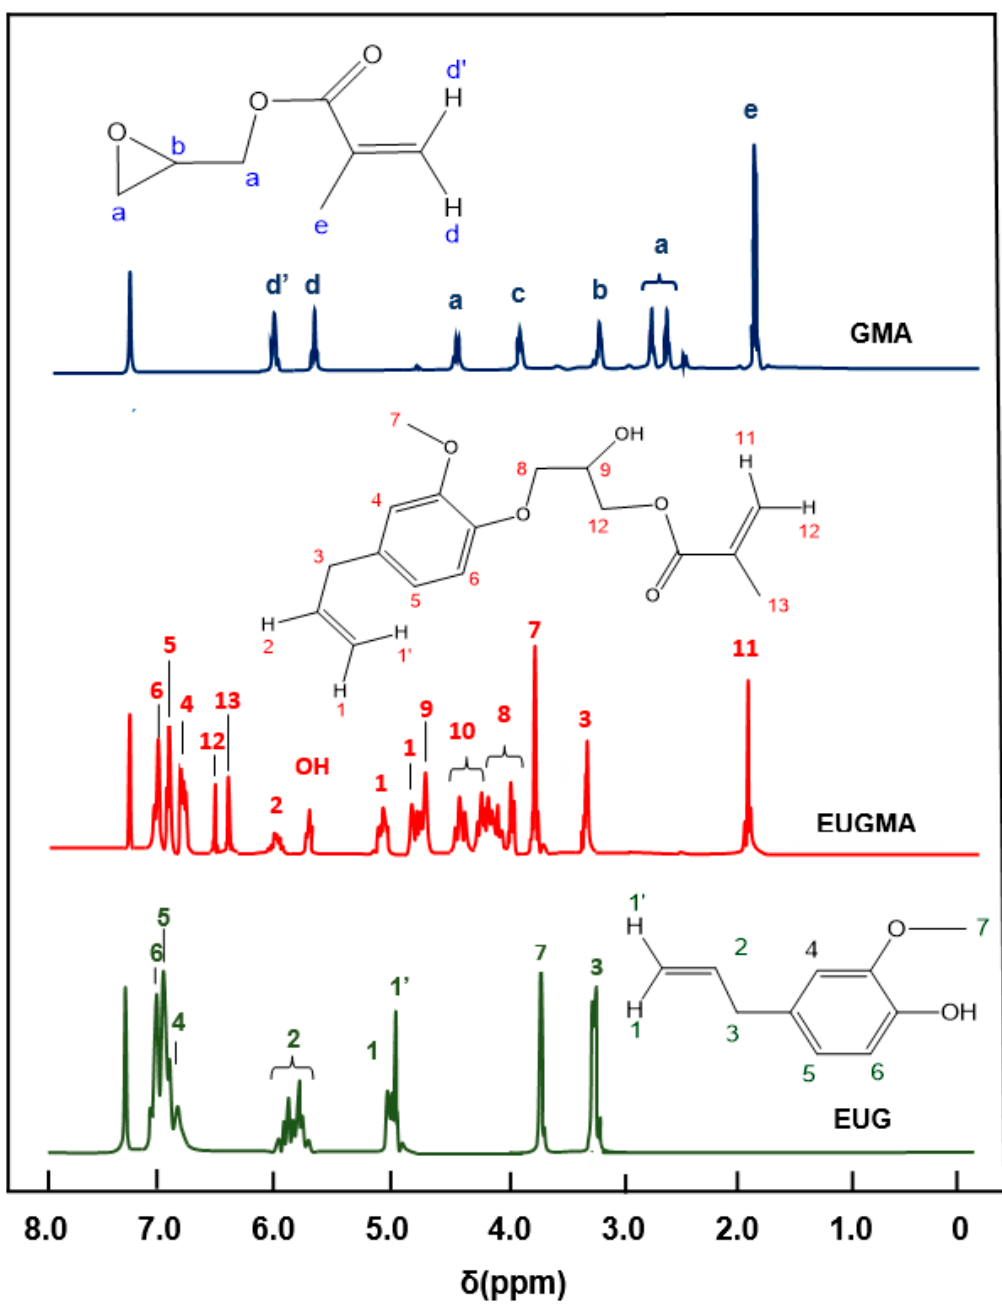
Figure 2. Proton nuclear magnetic resonance ( 1 H NMR) spectra of EUG, GMA, and EUGMA in CDCl 3 .